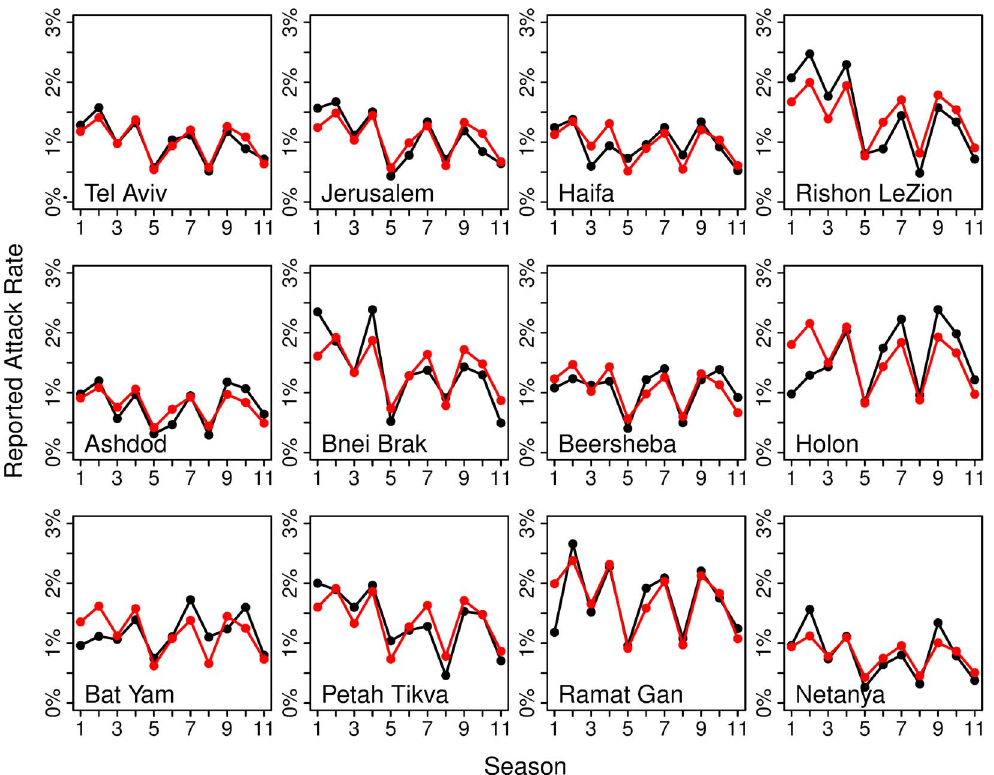
Figure 3. Observed vs. expected attack rates. Reported attack rates in each city in each season (black) compared to expected results from model fits (red) using equations 5–6. The expected attack rates in all cities are identical up to a scaling factor of the reporting rate. Note the good fit between the expected and observed attack rates in most cities in most seasons.